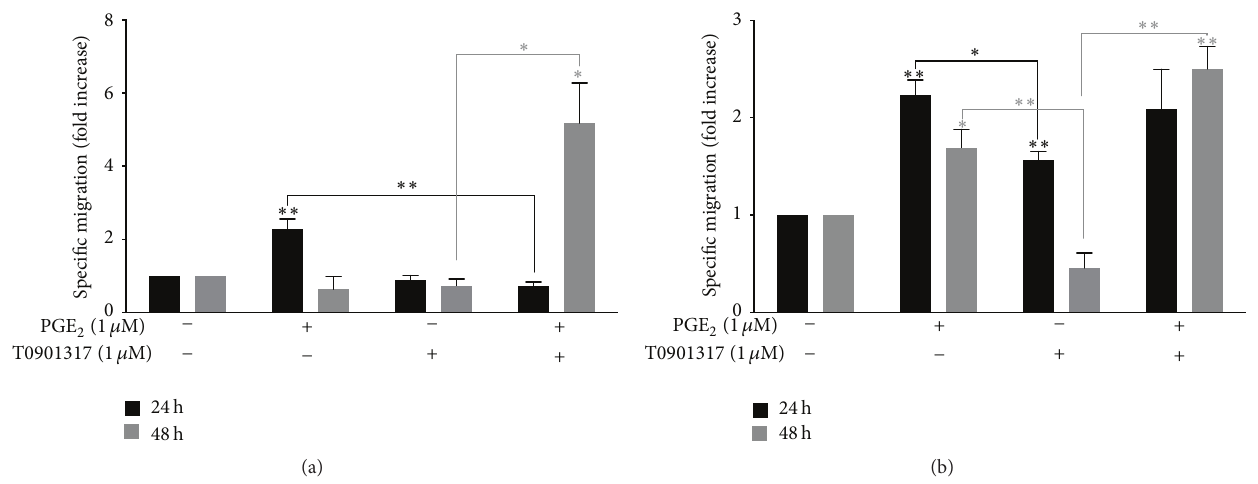
Figure 2: PGE 2 alone and in combination with T0901317 induces functional CCR7-specific migration of MM-1 cells. Chemotaxis assays in response to 300 ng/mL CCL19 (a) or CCL21 (b) were performed in MM-1 cells stimulated for 24h (filled black) or 48 h (filled gray) with 1 𝜇 M PGE 2 and 1 𝜇 M T0901317. The mean number of spontaneously migrating cells (that migrated to media alone) was subtracted from the number of cells that migrated in response to CCL19 or CCL21. Data represent mean ± SD of three independent experiments. ∗ 𝑝 < 0.05 , ∗∗ 𝑝 < 0.01 .